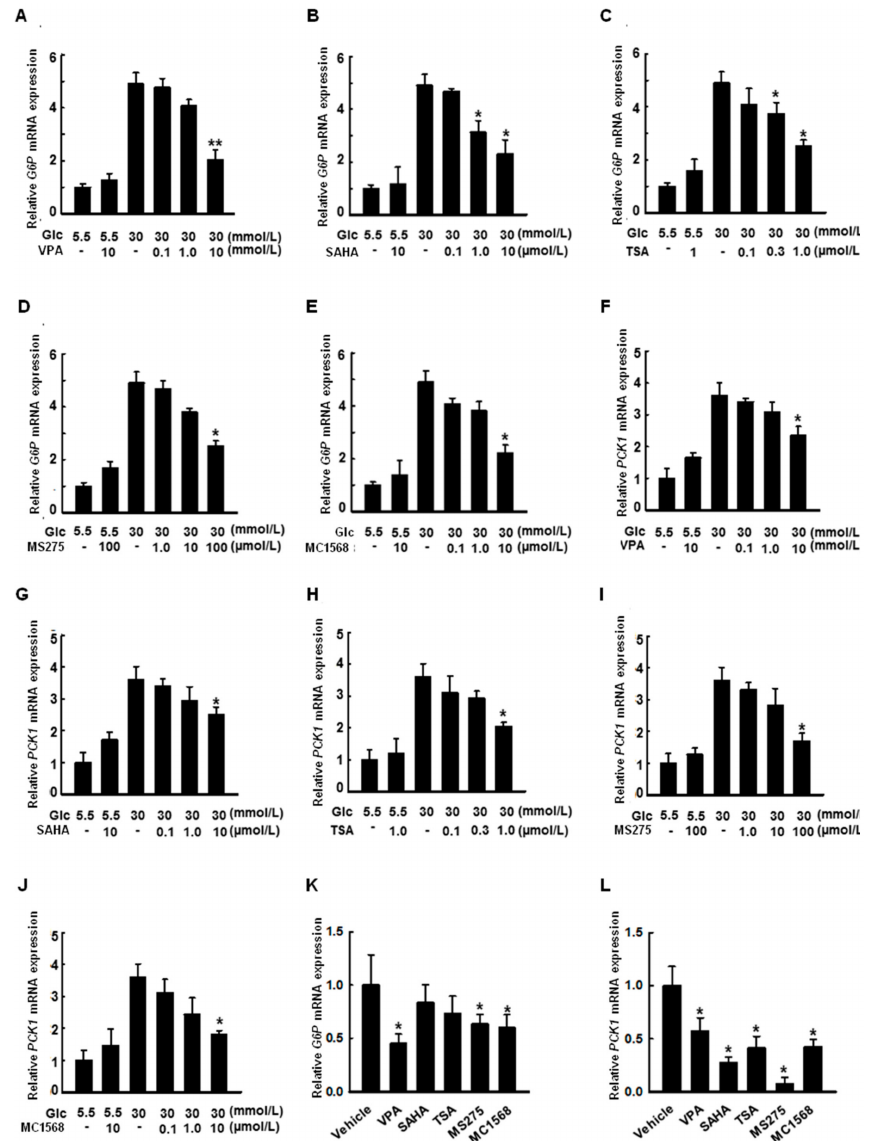
Figure 6. Histone deacetylase (HDAC) inhibitors reduce the expression of G6P and PCK1 in HepG2 cells. Cells were treated with VPA (( A , F ), 0.1, 1.0, and 10 mmol/L); SAHA (( B , G ), 0.1, 1.0, and 10 µ mol/L); TSA ( C , H , 0.1, 0.3, and 1.0 µ mol/L); MS275 (( D , I ), 1.0, 10, and 100 µ mol/L); and MC1568 (( E , J ), 0.1, 1.0, and 10 µ mol/L) for 48 h under hyperglycemic conditions. Expression of G6P or PCK1 was quantified by RT-qPCR. Cultivation under hyperglycemic conditions increased the expression of G6P or PCK1 , an effect that was attenuated by treatment with the pan-HDAC inhibitors VPA, SAHA, and TSA, as well as the HDAC class I-specific inhibitor, MS275, and the HDAC class IIa-specific inhibitor, MC1568. The graphs show the mean ± SEM of three independent experiments (* p < 0.05, ** p < 0.01 vs. vehicle in 30 mmol/L glucose). HDAC inhibitors (VPA, 10 mmol/L; SAHA, 10 µ mol/L; TSA, 1.0 µ mol/L; MS275, 100 µ mol/L; MC1568, 10 µ mol/L, for 24 h) also decreased the expression of G6P or PCK1 in the absence of glucose ( K , L ). The graphs show the mean ± SEM of three independent experiments (* p < 0.05 vs. vehicle in 0 mmol/L